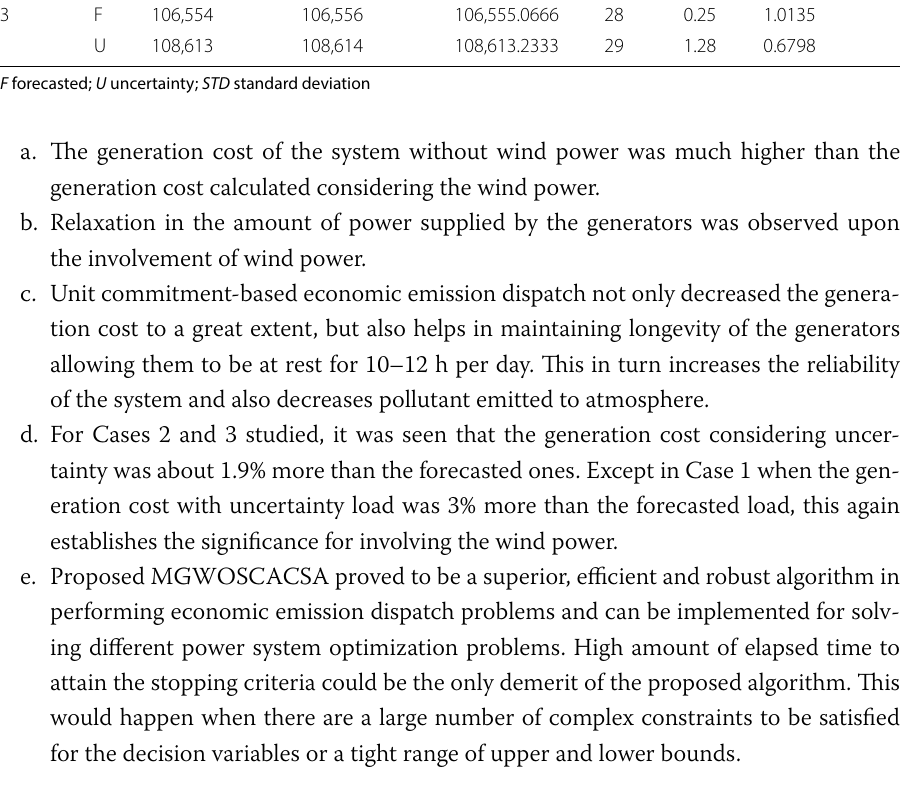
F forecasted; U uncertainty; STD standard deviation